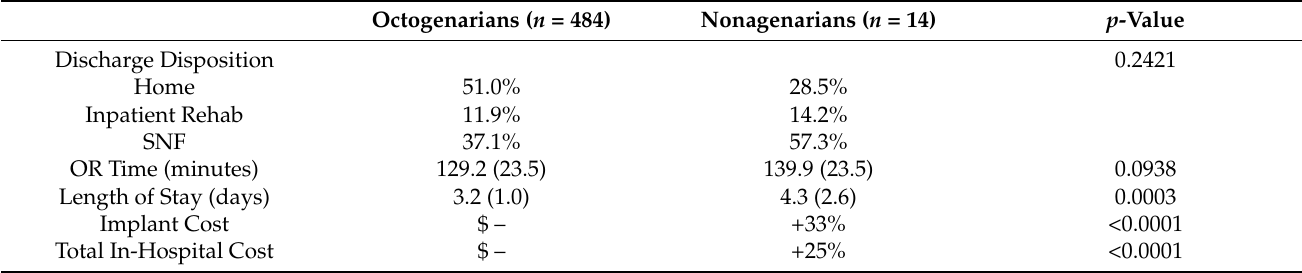
Table 3. Comparing outcomes and costs for total knee arthroplasty between octogenarians and nonagenarians. SNF = skilled nursing facility. OR = operating